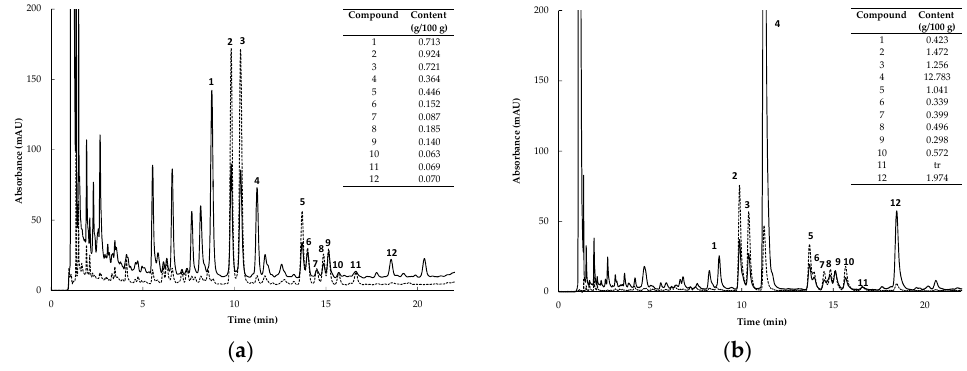
Figure 1. HPLC chromatograms of ( a ) FRE (fermented rooibos extract) and ( b ) GRT (unfermented rooibos extract) at 288 and 350 nm (solid and dotted lines, respectively). Content values of compounds are expressed as g/100 g extract ( 1 , PPAG ( Z -2-( β - D -glucopyranosyloxy)-3-phenylpropenoic acid), 2 , isoorientin; 3 , orientin; 4 , ASP (aspalathin); 5 , quercetin-3- O -robinobioside; 6 , vitexin; 7 , hyperoside; 8 , rutin; 9 , isovitexin; 10 , isoquercetrin; 11 , luteolin-7- O -glucoside, and 12 , nothofagin).